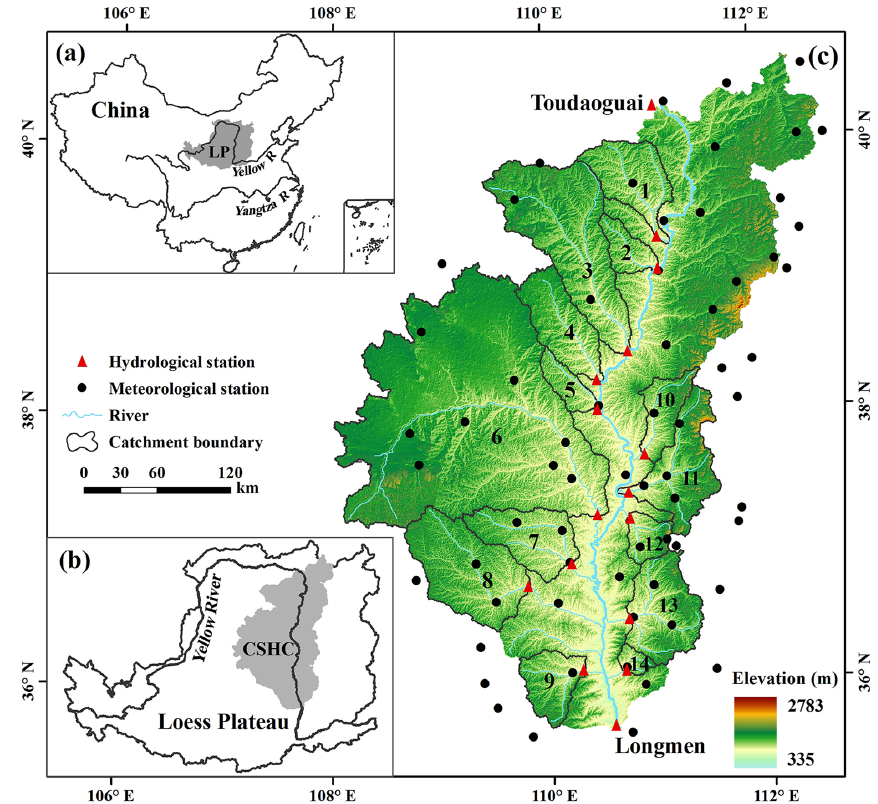
Figure 1. Location of the studied catchments in the Coarse Sandy Hilly Catchments (CSHC) region within the Loess Plateau.